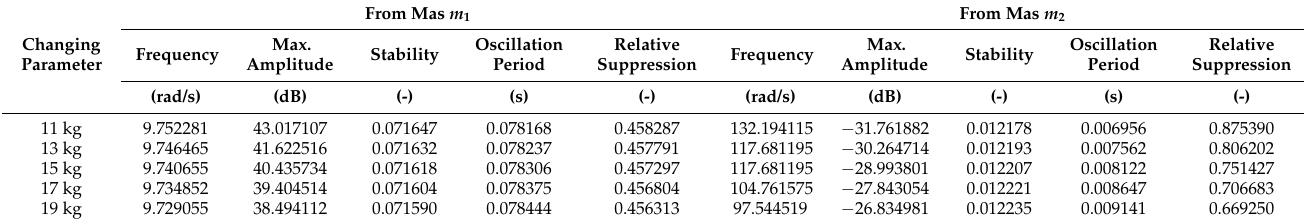
Figure 11. Amplitude and phase characteristics of the transmittance of the steering angle position when the parameter value is changed 𝑚 (cid:2869) . Table 5. The values of the parameters read from the graphs shown in Figure 11. Changing Parameter